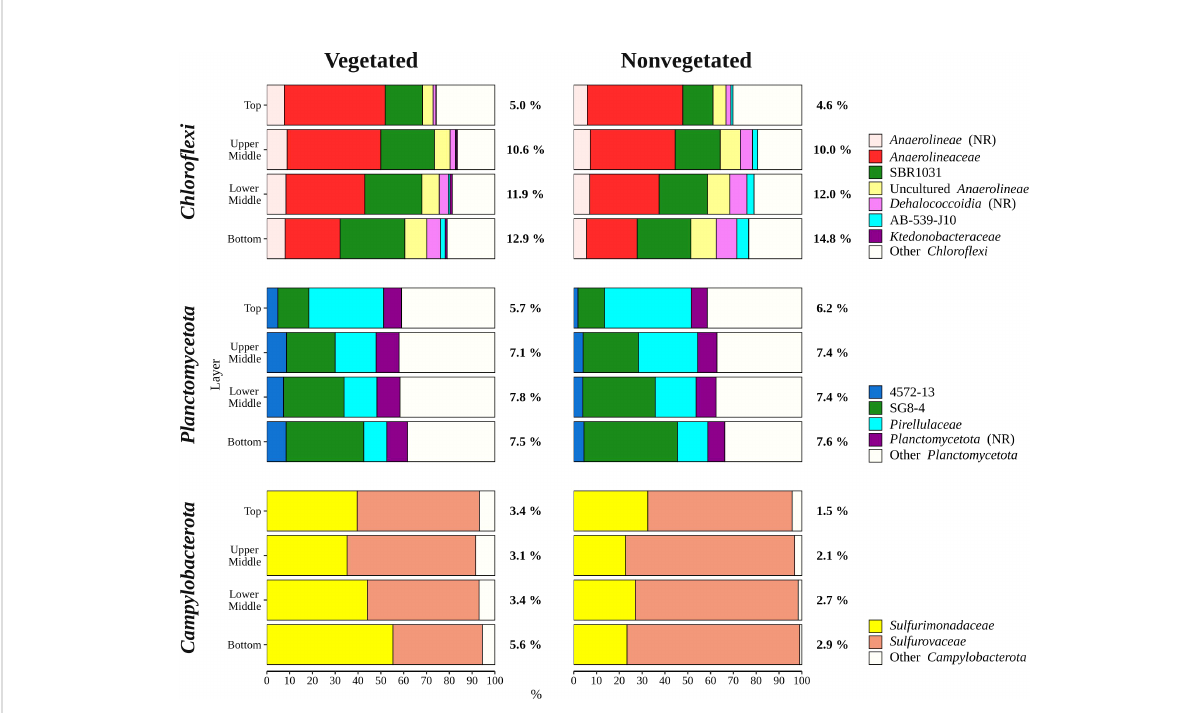
FIGURE 7 Taxonomic classi fi cation and relative contribution of the most abundant ( ≥ 1%) taxonomic groups within Chloro fl exi , Planctomycetota , and Campylobacterota in sediment communities sampled at the vegetated and nonvegetated site in the Bay of Saline. NR – sequences without known